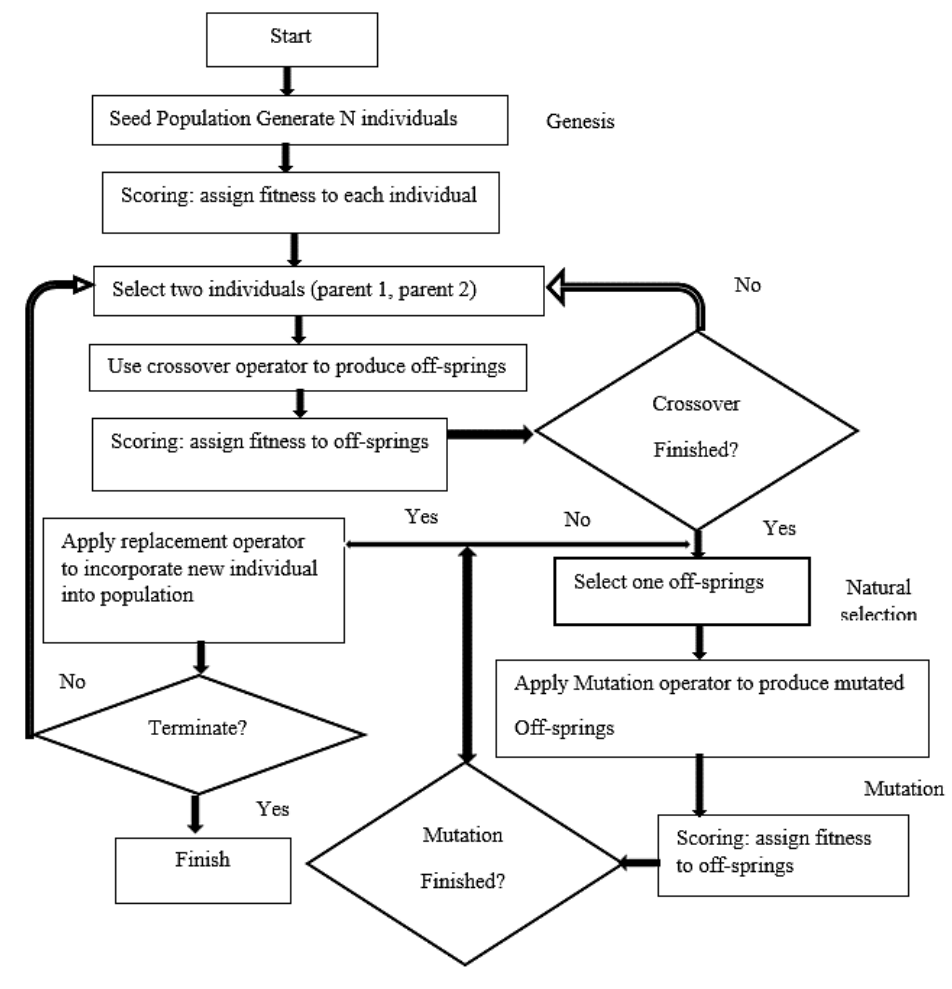
Figure 1. The block diagram representation of genetic algorithms